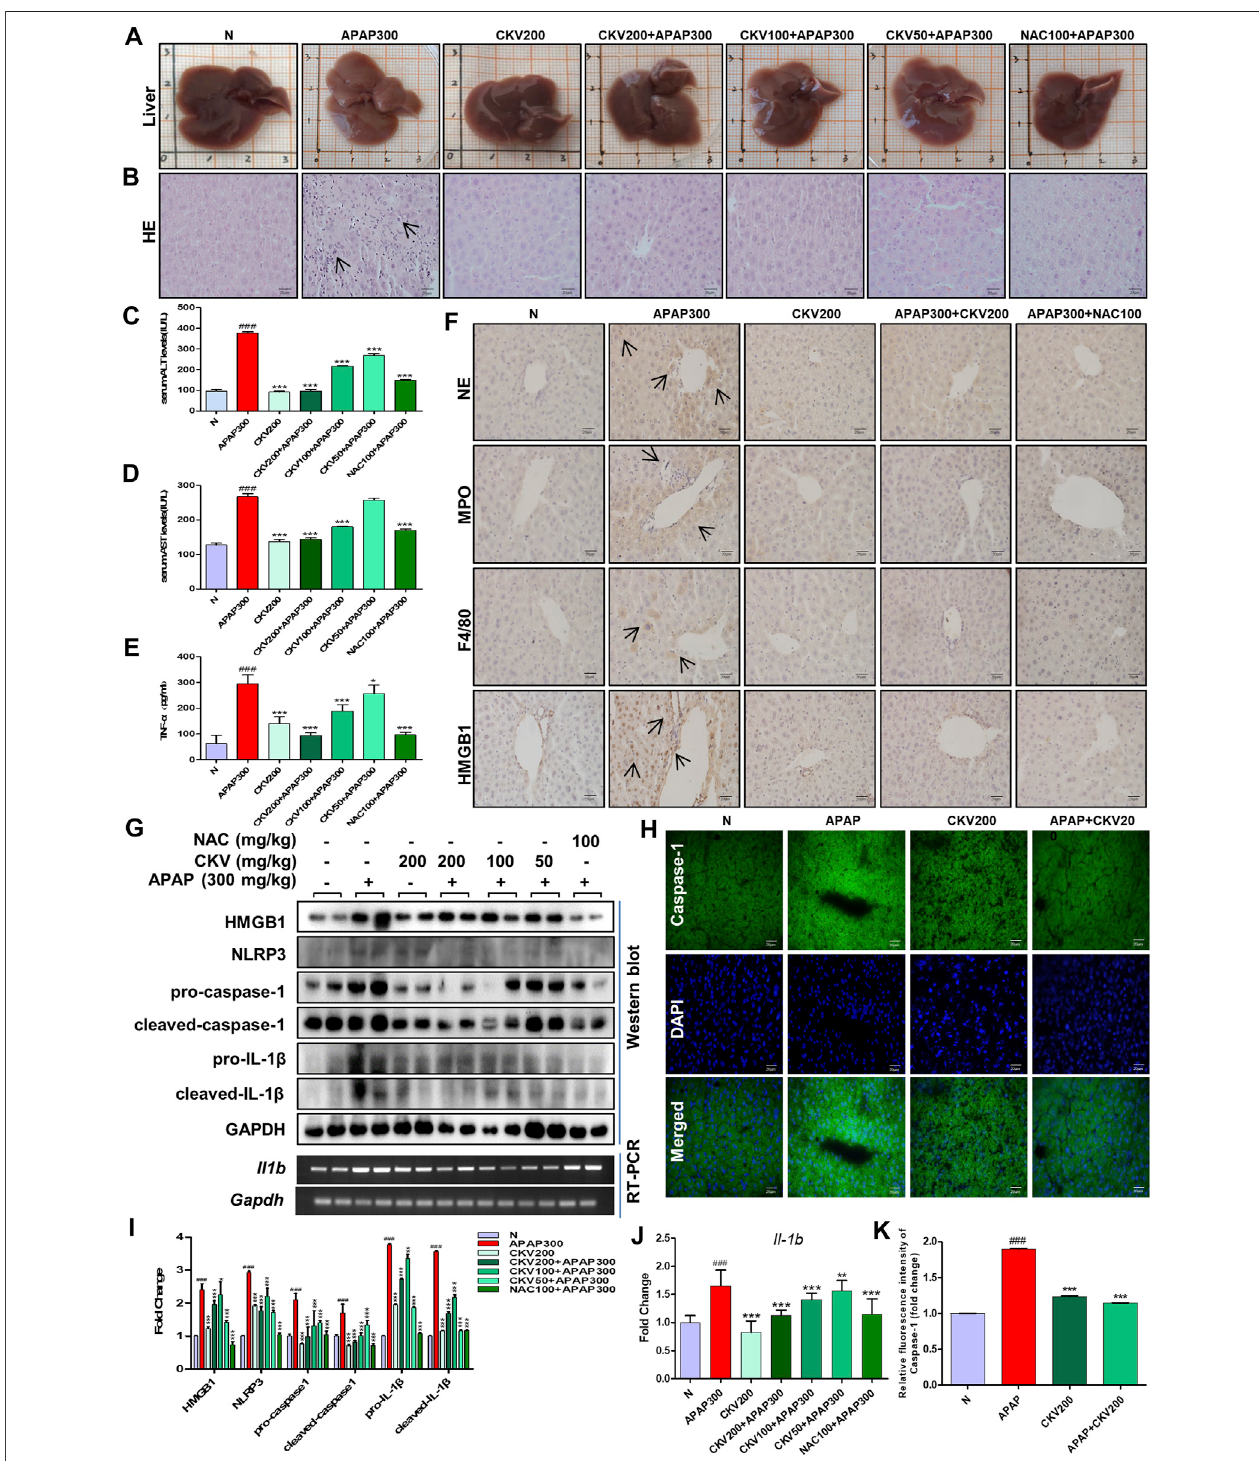
FIGURE 9 | Effect of CKV on liver injury and in fl ammation induced by APAP in mice. C57BL/6 mice were randomly divided into normal group, APAP alone group, APAP combined with CKV (200 mg/kg), CKV (100 mg/kg) or CKV (50 mg/kg) group, positive drug NAC (100 mg/kg) control group, and CKV (200 mg/kg) alone treatment group. CKV was given 1 h before APAP treatment, and mice were sacri fi ced 12 h after APAP treatment to collect samples. (A) Morphology of mouse liver tissue samples. (B) HE staining. (C,D) The level of ALT and AST in serum. (E) The ELISA results of different concentrations of CKV on the expression of TNF- α in serum of mice induced by APAP. (F) Immunohistochemical staining of NE, MPO, F4/80 and HMGB1. (G) The protein expression of HMGB1, NLRP3, pro-caspase1,